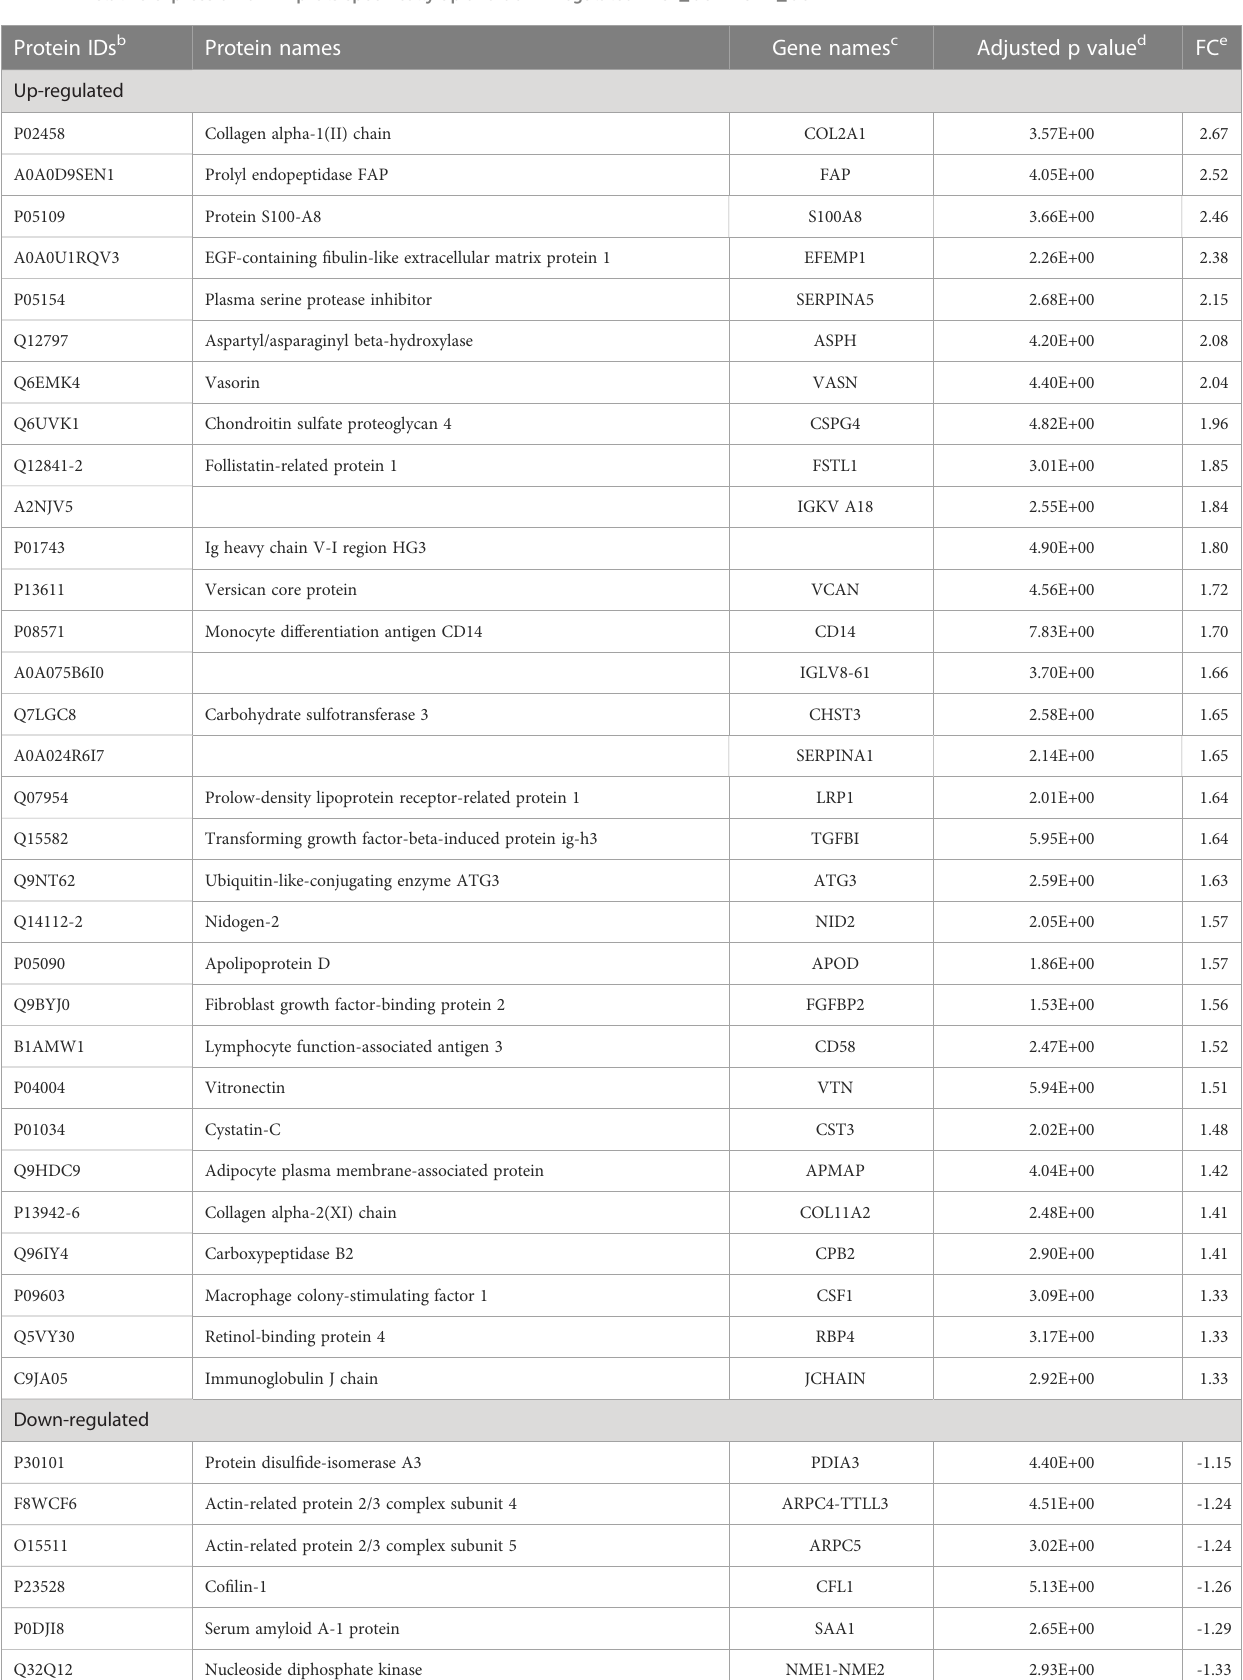
TABLE 2 Relative expression of EV-prots speci fi cally up and down-regulated in SF_OJIA vs PL_OJIA a . Protein IDs